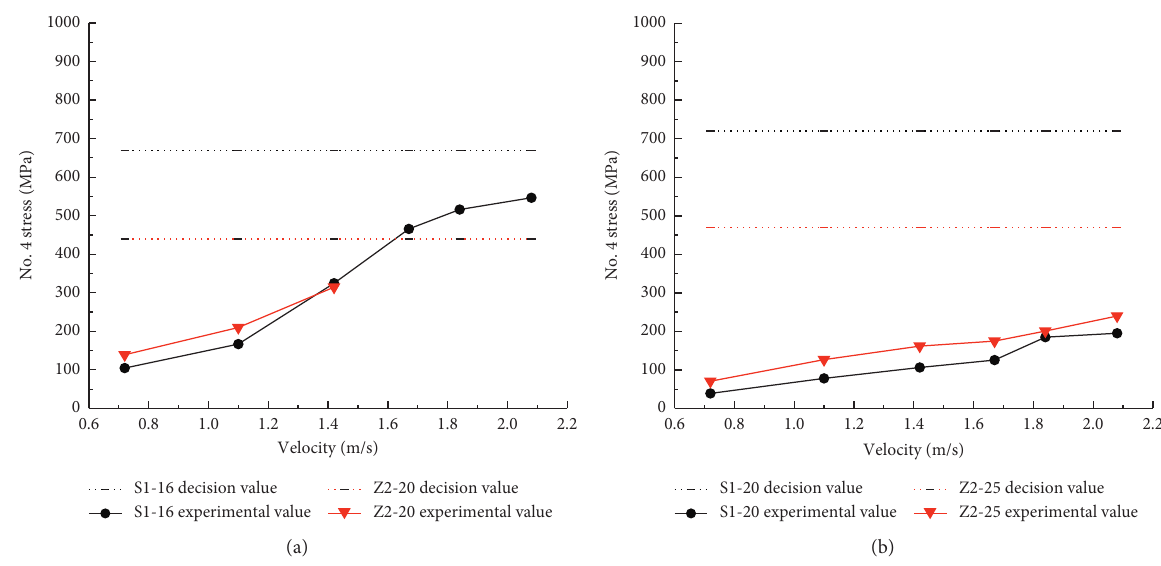
Figure 15: Fitting of stress and impact velocity of #4 reinforcement. Note: the reinforcement reaches yield when Z2-20 is 1.42m/s, at which point its elastic modulus cannot be determined, and thus only the first three values are